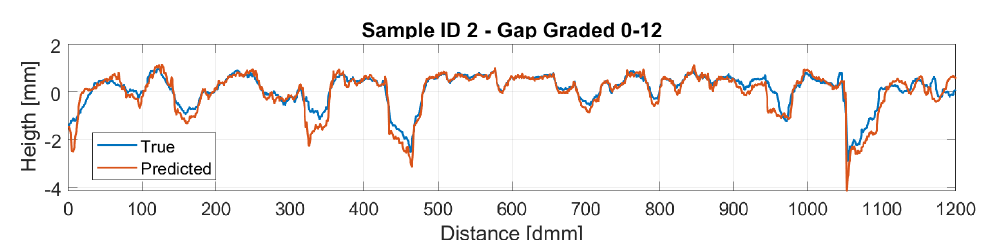
Figure 16. Sample 1 Reconstruction.